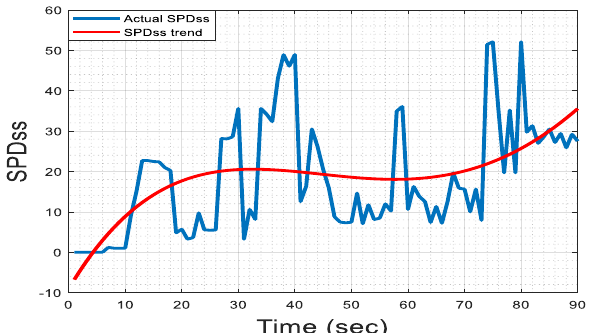
Figure 18. Single scale version of spatial efficient entropic differencing (SPDss) plot for the video used in the study.